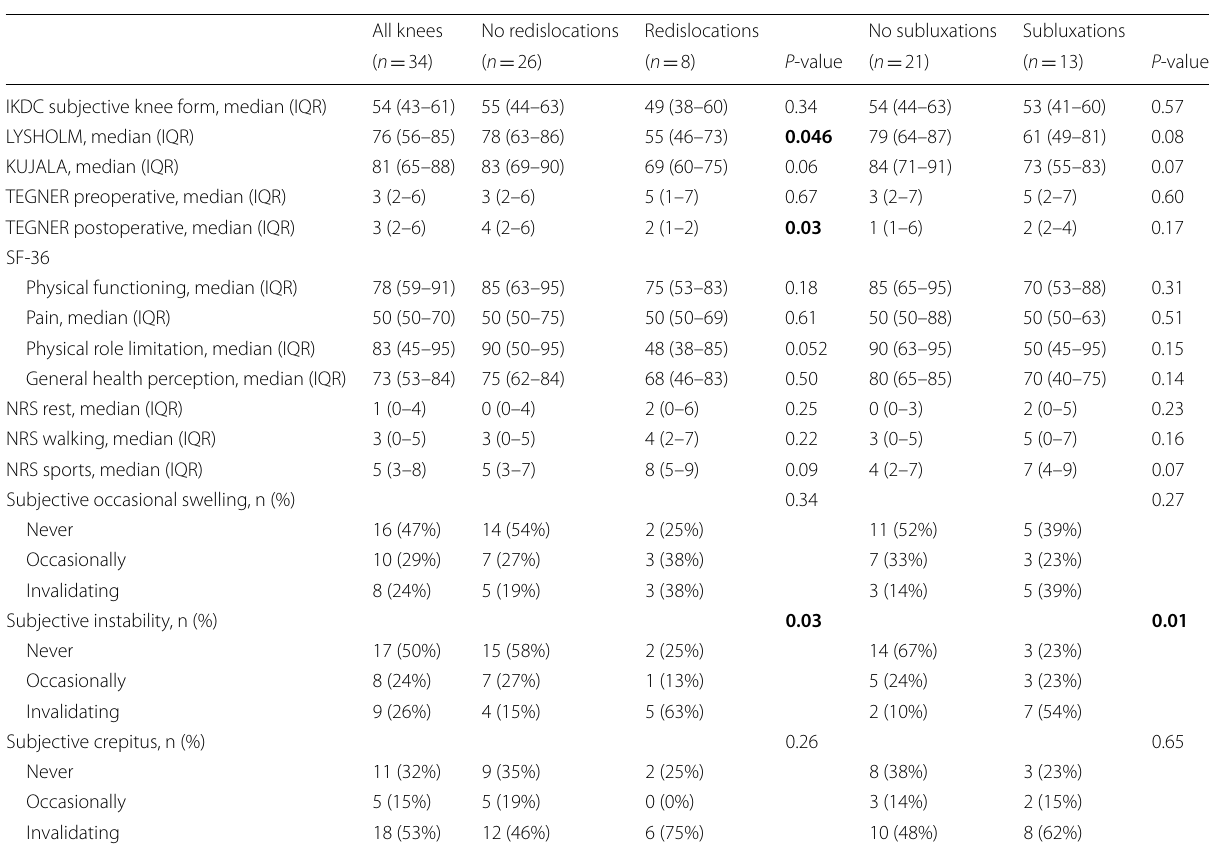
Table 3 Functional